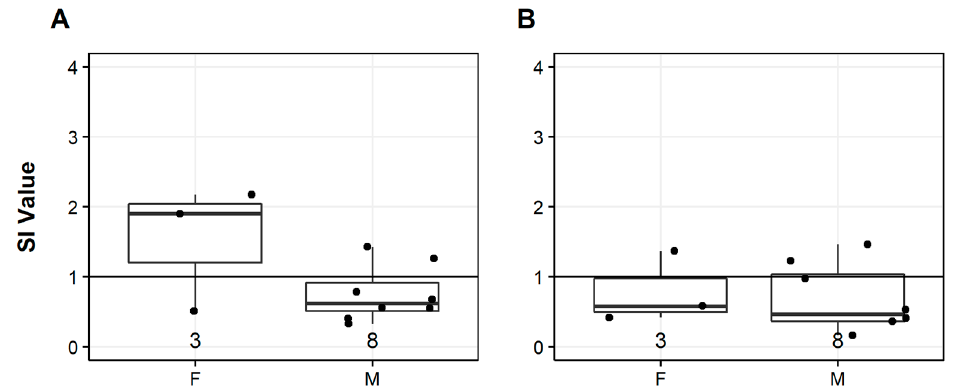
Figure 8. Fall 2019 mitogenesis responses of IgM − ( A ) and IgM+ ( B ) lymphocytes in response to LPS stimulation for smallmouth bass ( Micropterus dolomieu ) females (F) and males (M) at the Cheat River site. The horizontal line at 1 indicates the stimulation index (SI) threshold, the dots represent individual data points, and the number indicates sample size (n). Median (line in box) and interquartile range (box) are displayed with the vertical lines indicating highest and lowest values within 1.5 times above and below the interquartile range.